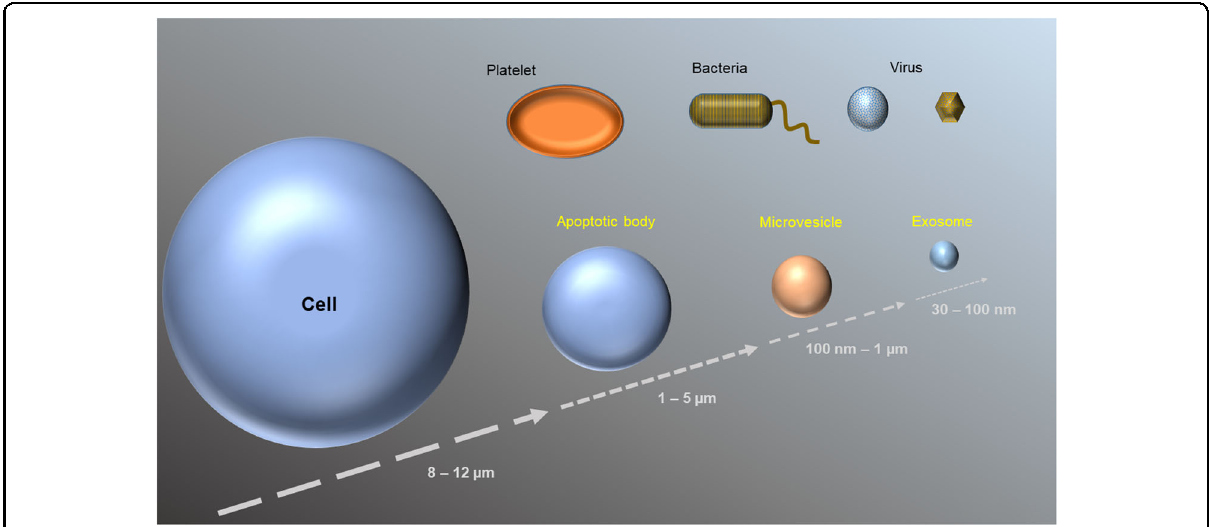
Fig. 1 Size distributions of EVs derived from mammalian cells. The sizes of three types of EVs are compared to those of other small structures, including cells, platelets, bacteria, and